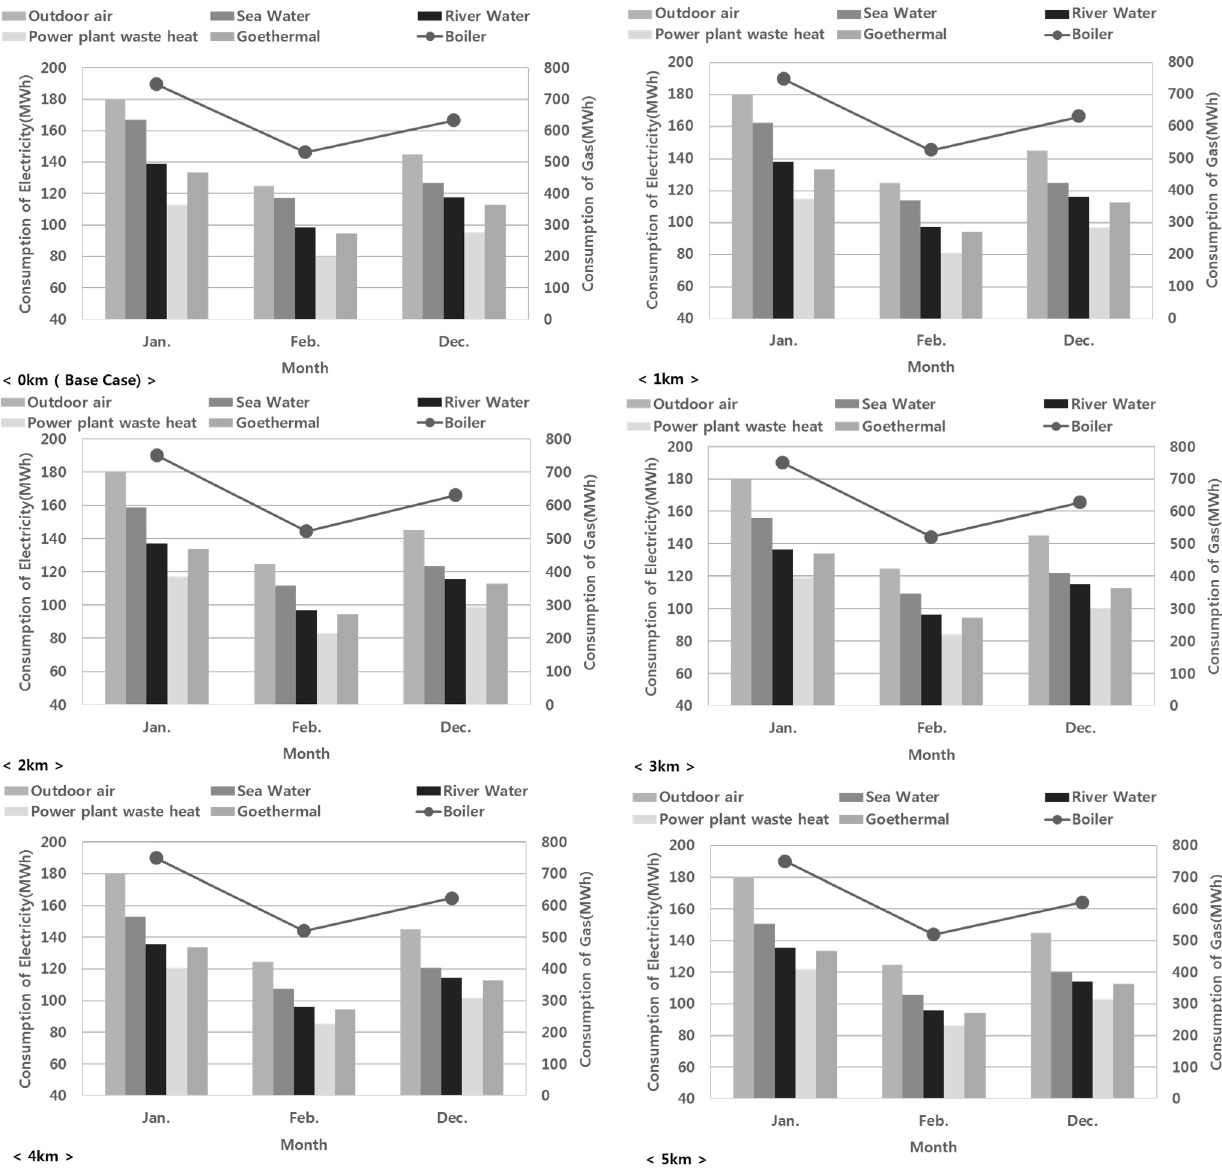
Figure 6. Accumulated electricity and gas consumption on the winter season for each heat source according to the pipe distance (W/m 2 )